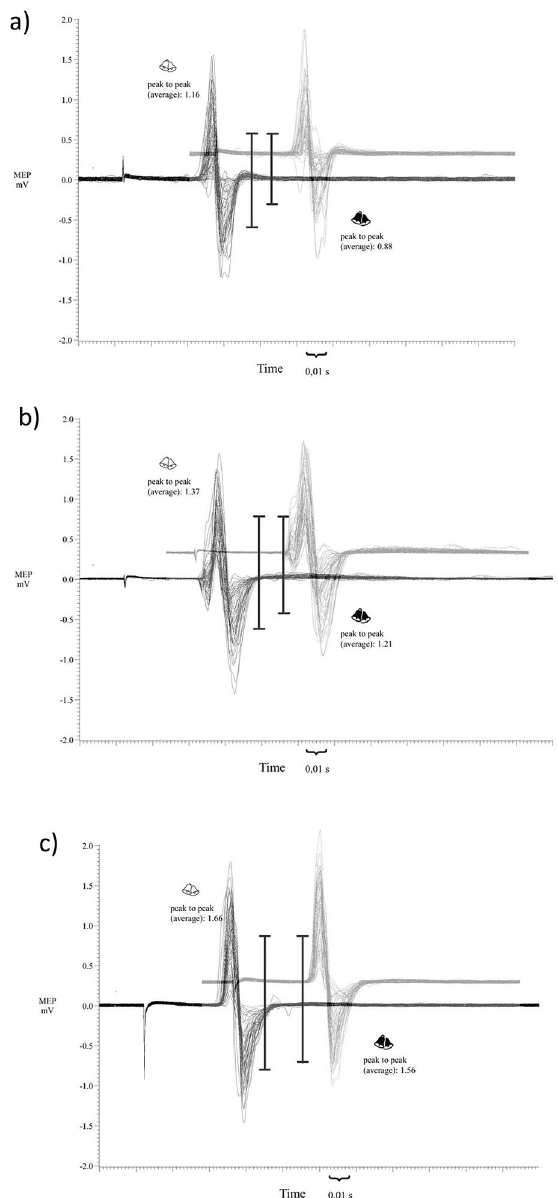
Figure 4. Three exemplary participants—one for each of the three groups (i.e., ( a ) < 1 mV, ( b ) < 2 mV, ( c ) < 3 mV, see Fig. 3). Shown is an overlay of single-pulse MEP responses during the test phase separated into those combined with the conditioned tone (white bells) and those combined with the control tone (dark bells). Vertical lines besides the MEPs index the average across all single-pulse MEP amplitudes during the test phase. Please note that the difference between the MEP combined with the conditioned tone and the MEP with the control tone is strongest for the participant who presented paired-pulse MEP amplitudes during the conditioning phase below 1 mV ( a ). For the participant with paired-pulse MEP amplitudes below 2 mV the conditioning effect became weaker ( b ), whereas the participant with median paired-pulse MEP amplitudes below 3 mV showed the weakest conditioning effect ( c